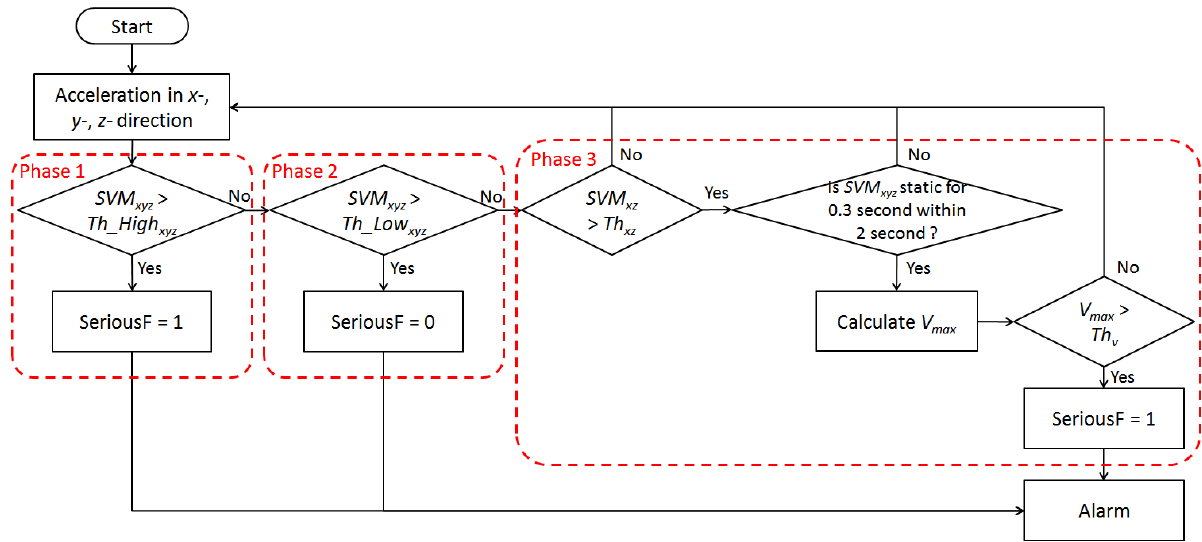
Figure 5. The fall detection